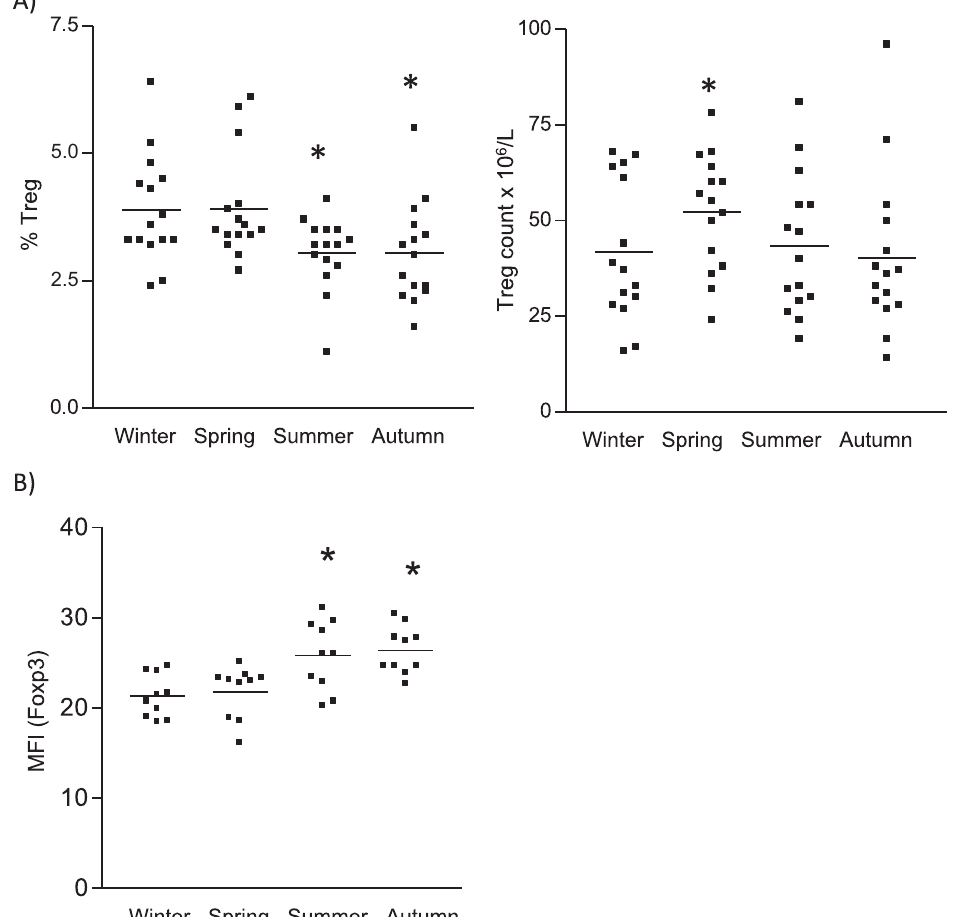
Figure 3. Seasonal variation in numbers and Foxp3 expression of Treg during the four seasons. A) Percentage (within CD4 + T cells) and absolute numbers of CD4 + CD25 hi CD127 2 Treg and B) level of Foxp3 expression (mean fluorescence intensity; MFI). Whole blood and PBMC isolated from 15 healthy volunteers during each season were analyzed for the respective markers using flowcytometry. Data show results from 15 healthy donors. * p , 0.05 as compared to